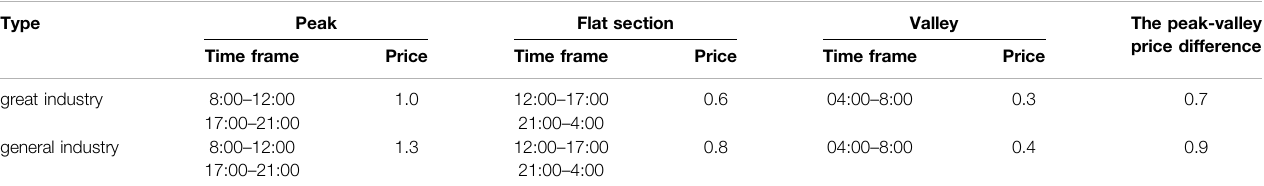
TABLE 2 | TOU power